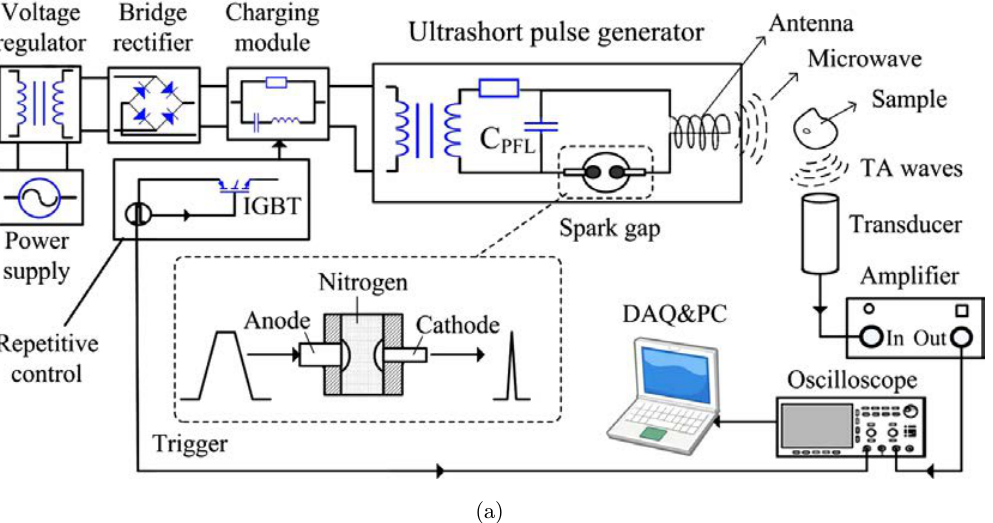
Fig. 4. (a) Schematic diagram of the experimental setup of USMP TAI. (b) The comparison of microwave pulses of the USMP and the microsecond-level TAI. (c) The microwave pulse of the USMP.